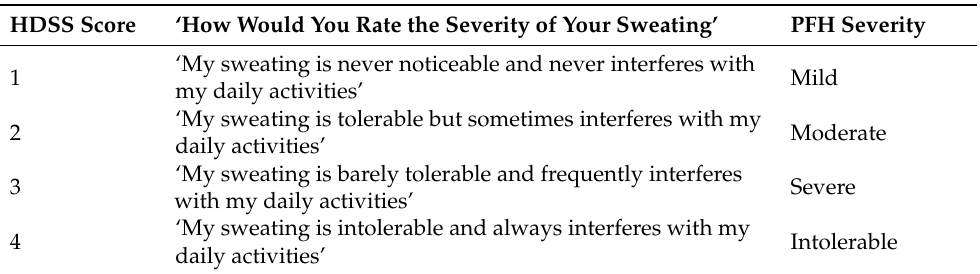
Table 2. Hyperhidrosis Disease Severity Scale (HDSS). Only patients rating the severity of their PFH as severe (HDSS 3) or intolerable (HDSS 4) qualify for surgery. HDSS